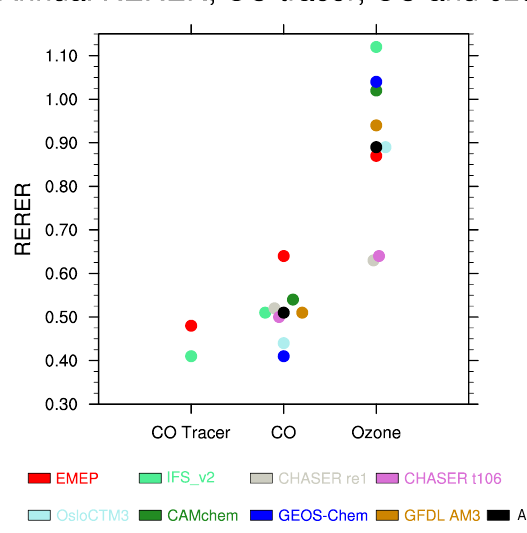
Figure 2. Model-calculated annual CO tracer, CO and ozone RERER (Response to Extra-Regional Emission Reductions) values for Europe calculated by the models; see equation in Sect. 4. Similar RERER values have been displaced